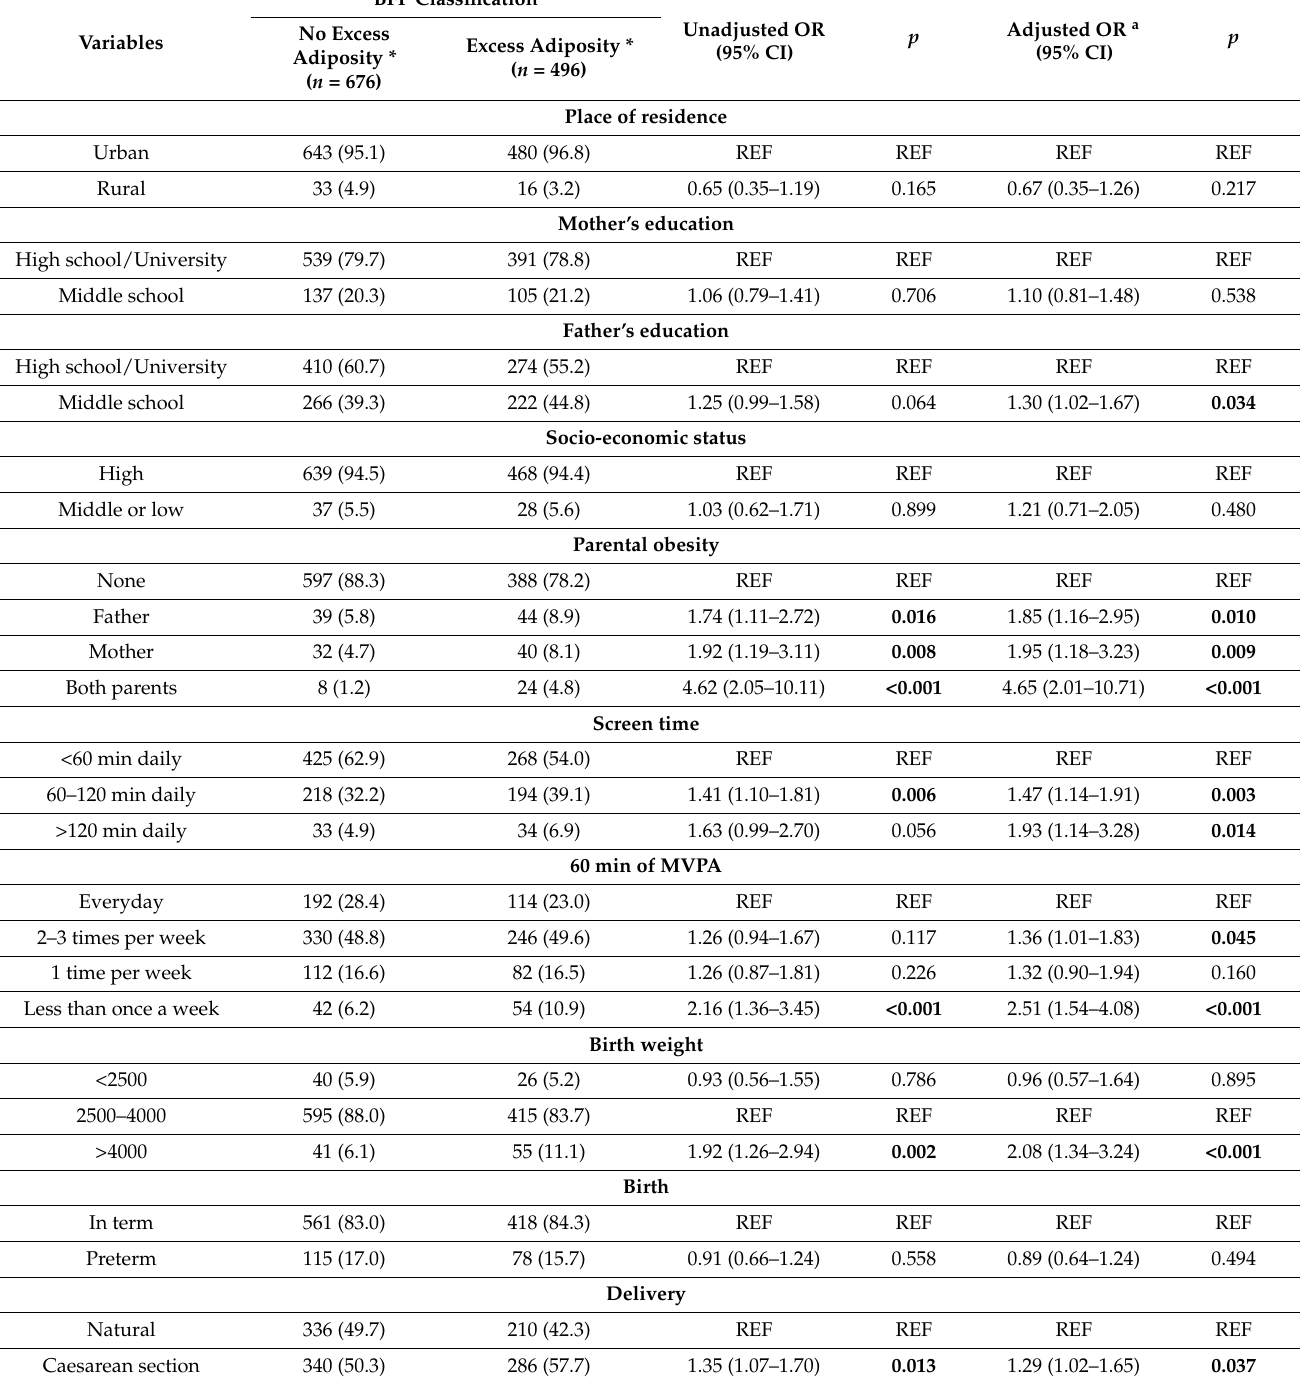
Table 4. Factors associated with excess adiposity-logistic regression